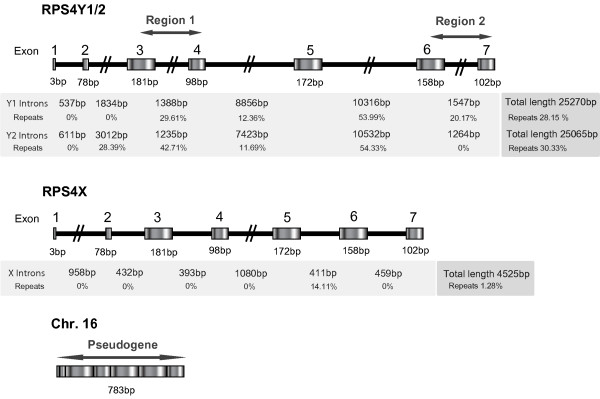
Genomic structure of human RPS4 genes. Exonic and intronic lengths and repeat content are shown. Amplified loci on the Y chromosome (regions 1 and 2) and on the pseudogene are shown with arrows.